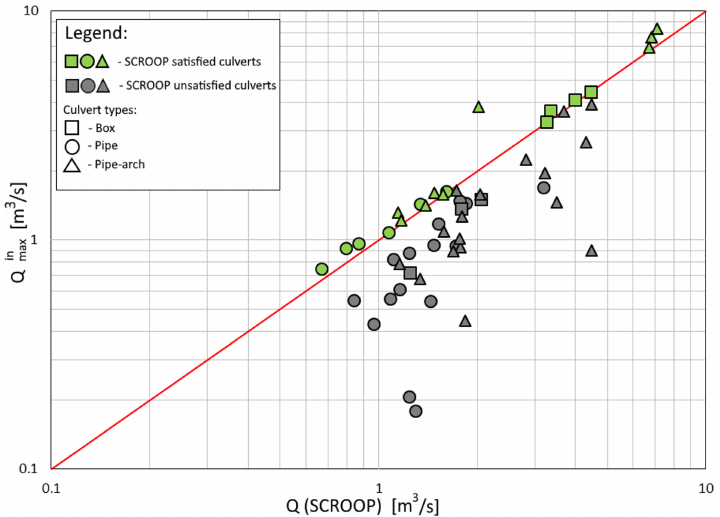
Figure 9. Results of the second phase of analysis: checking if the existing condition of culverts meets the